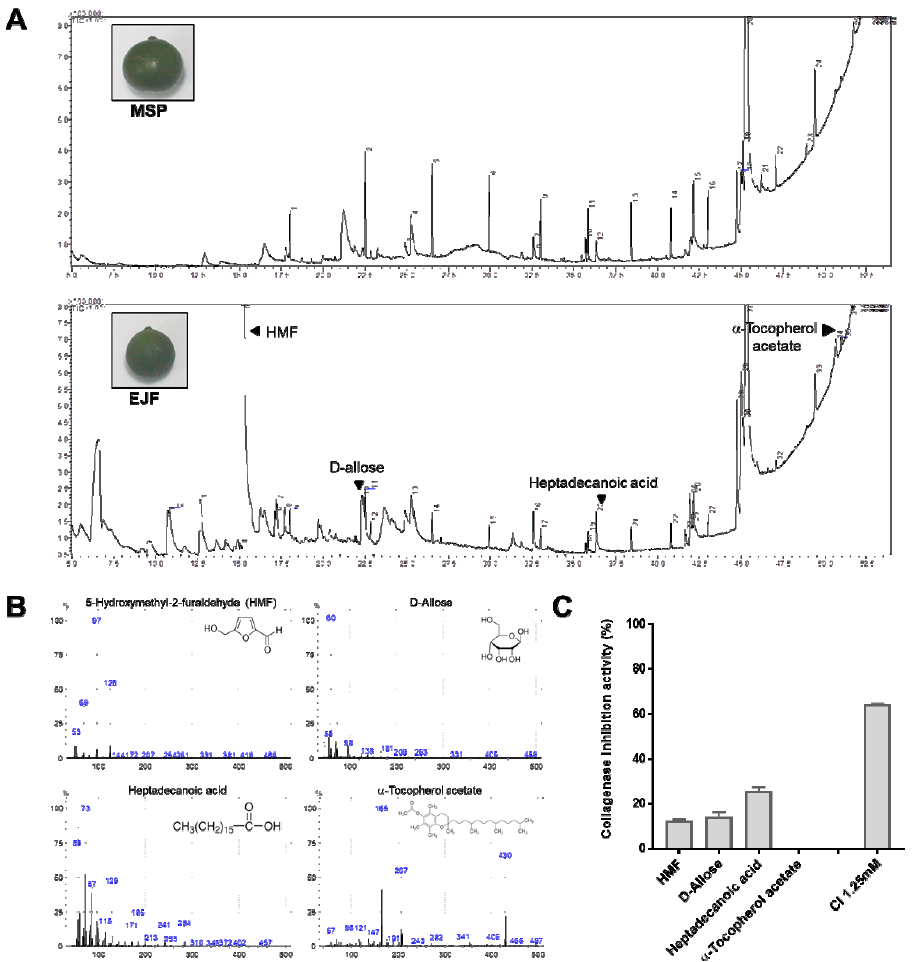
Figure 3. ( A ) GC-MS chromatograph of C. unshiu extracts (MSP and EJF). ( B ) Candidate compounds of anti-aging activity by gas chromatography-mass spectrometry (GC-MS). ( C ) Collagenase inhibitory activity of four candidate compounds. Data are expressed as mean ± SD (n = 3), and different small letters indicate a significant difference by Duncan’s test; p < 0.05.